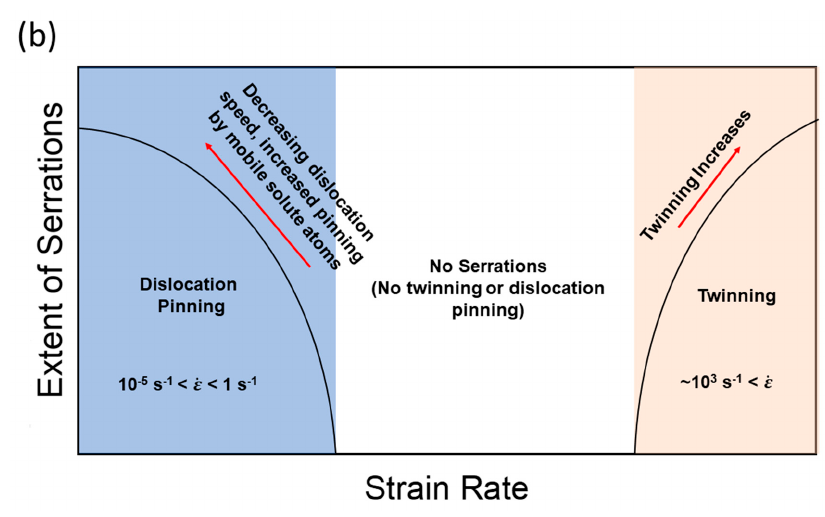
Figure 49. Basic schematics of the extent of serrations as a function of ( a ) temperature and ( b ) strain rate.